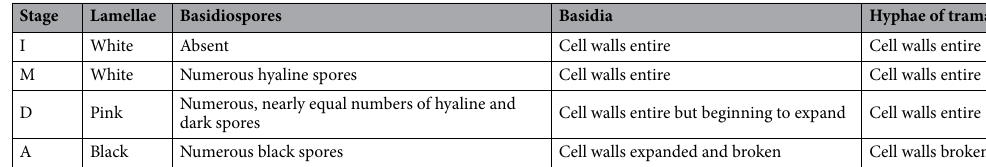
Table 2. Morphological characteristics of the four stages of fruiting body development in C. comatus